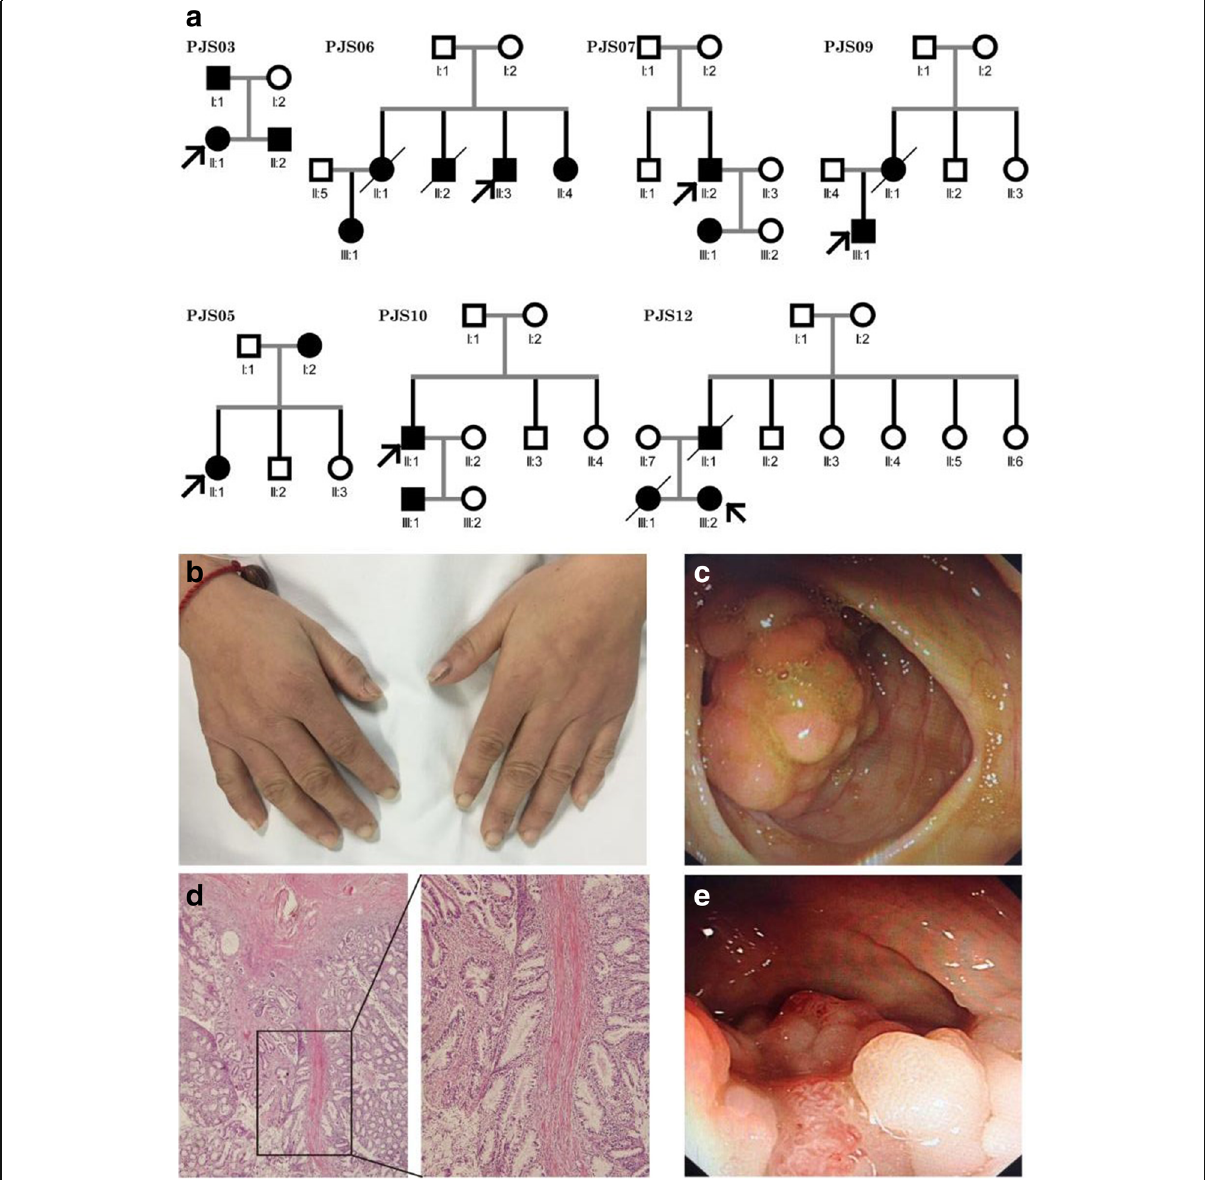
Fig. 1 Genogram and Clinicopathological feature of PJS patients. a Pedigrees of the 7 PJS cases with positive family history. Roman numerals indicate generations and Arabic numbers indicate individuals. Squares = males, circles = females. Affected individuals are denoted by solid symbols and unaffected individuals are denoted by open symbols. The probands are indicated by arrows. b and c . Melanin pigmentation spots of the fingers, endoscopic view of the recurrent polyp near the anastomotic stoma after the radical surgery of colon cancer and were observed in the proband of PJS03. d Hematoxylin-eosin-stained tissue slices of the polyp specimens above confirm hamartomatous. Left, × 40 magnification; right, × 100 magnification. e Endoscopic view of the polyps in PJS11, one of which had